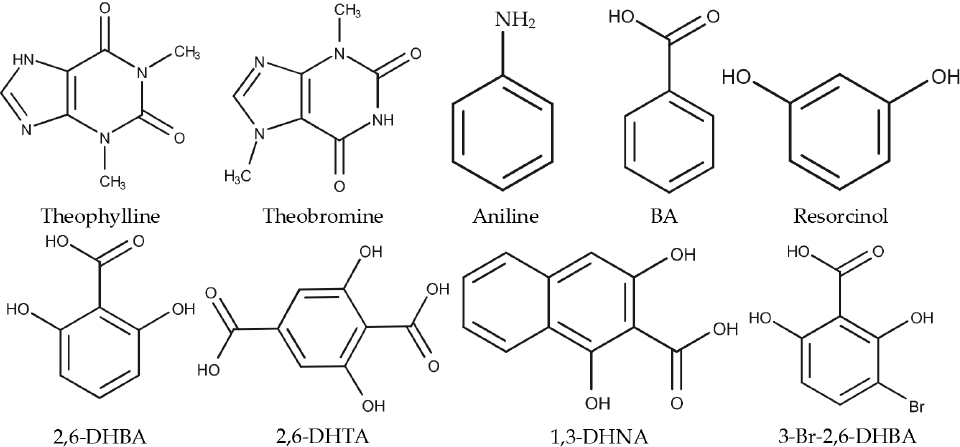
Figure 1. Structural formula of theophylline, theobromine, aniline, resorcinol, BA, 2,6-DHBA, 2,6- DHTA, 1,3-DHNA, and 3-Br-2,6-DHBA.